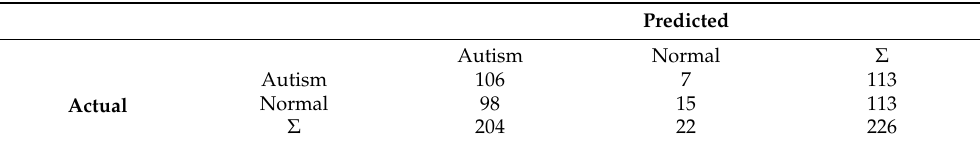
Table 9. Confusion matrix from Exp-2 (model trained with the Kaggle dataset but tested against the East Asian test dataset).